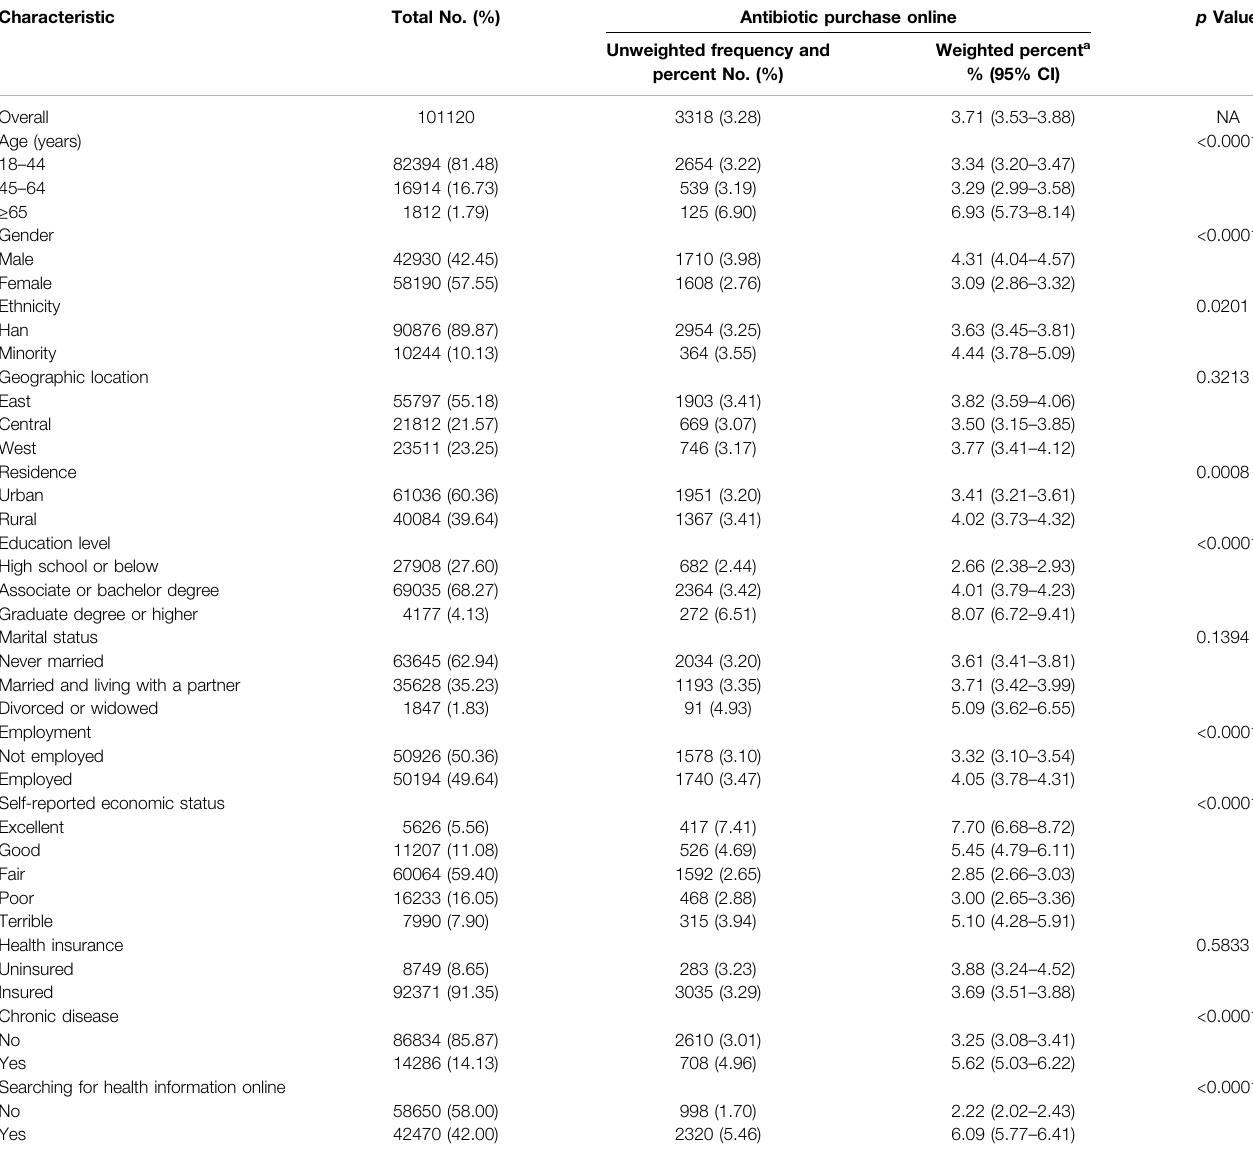
TABLE 1 | Resident ’ s characteristics and their associations with antibiotic purchase online in the past 3 months.